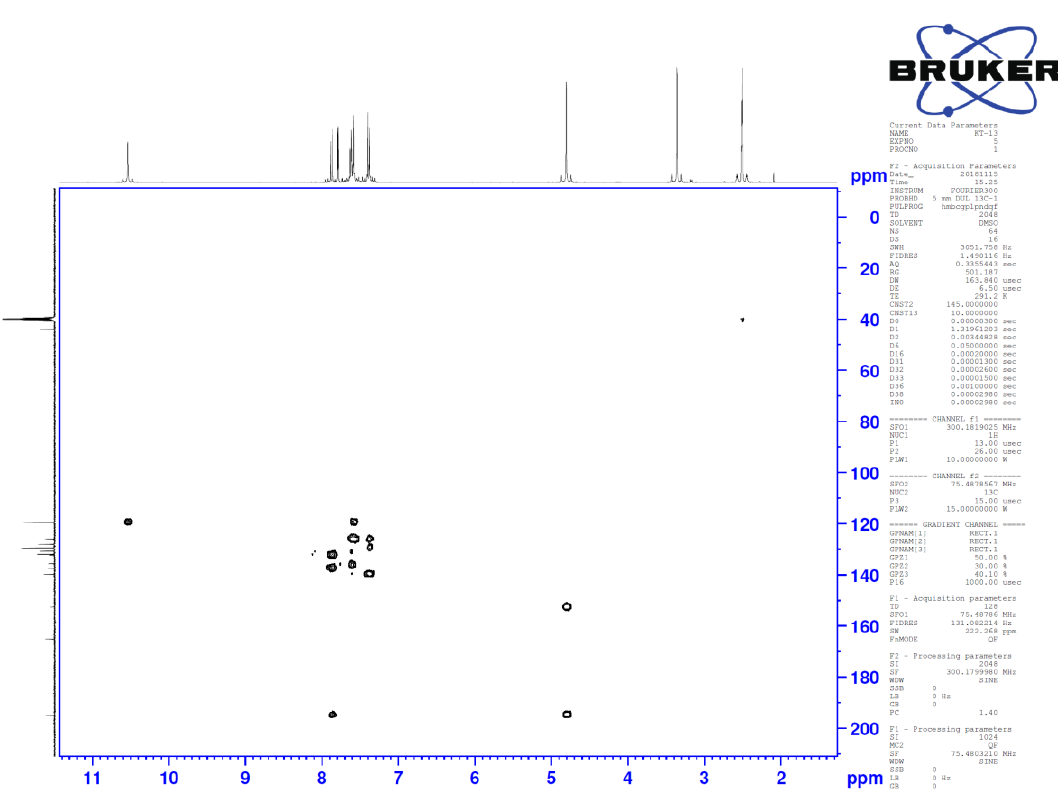
Figure 2. HMBC plot of compound 3l .